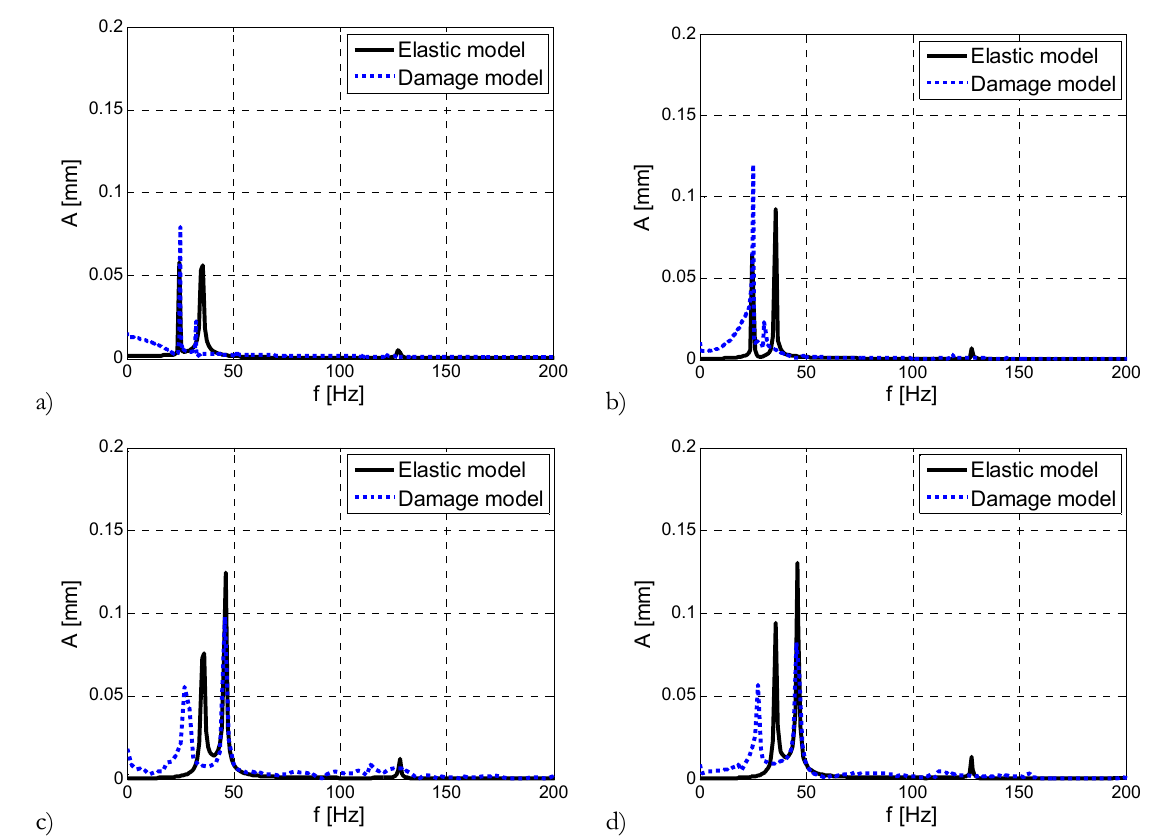
Figure 9: Fourier spectra of the displacement